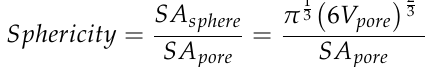
where SA is the surface area and V is the volume.